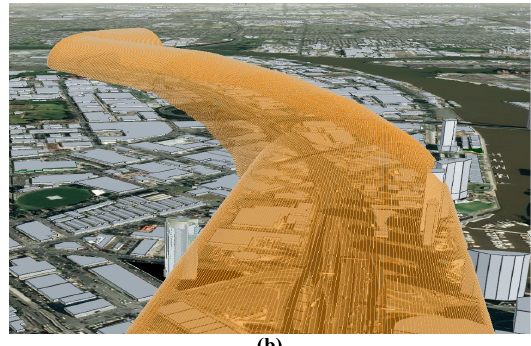
(b) Figure 7 . a) Noise influence area for different noise sources (adapted from Melbourne Planning Scheme Ordinance, p. 1281); b) noise impact regulation in 3D using